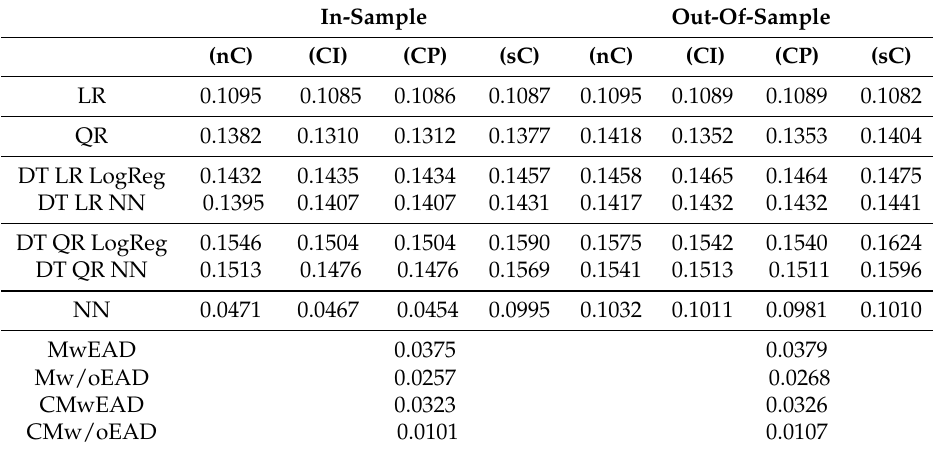
Table 6. In-sample and out-of-sample MSE for the estimated linear regression (LR), quantile regression (QR) models, decision trees (DT) with linear or quantile regression in the unit interval (LR/QR), and logistic regression or neural network for the classification problems (LogReg or NN), neural networks (NN), and mixture regression models (MwEAD, Mw/oEAD, CMwEAD, CMw/oEAD) for the four different cases nC (no crisis information), CI (inclusion of Crisis Indicator), CP (inclusion of Crisis Probability), sC (split data into crisis and non-crisis data